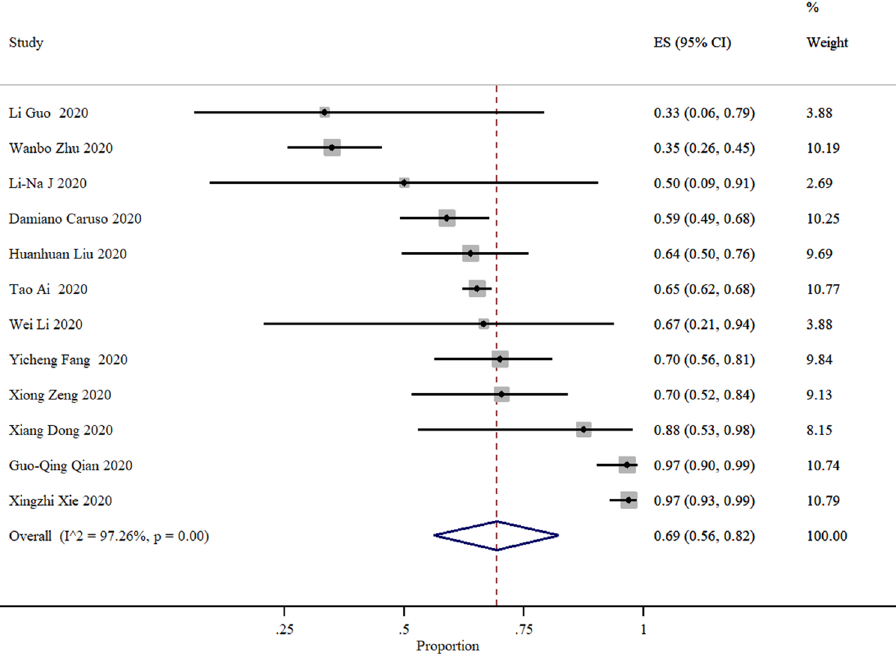
Figure 5. Summary of positive predictive value and 95% CI of 18 studies, generated by the STATA.